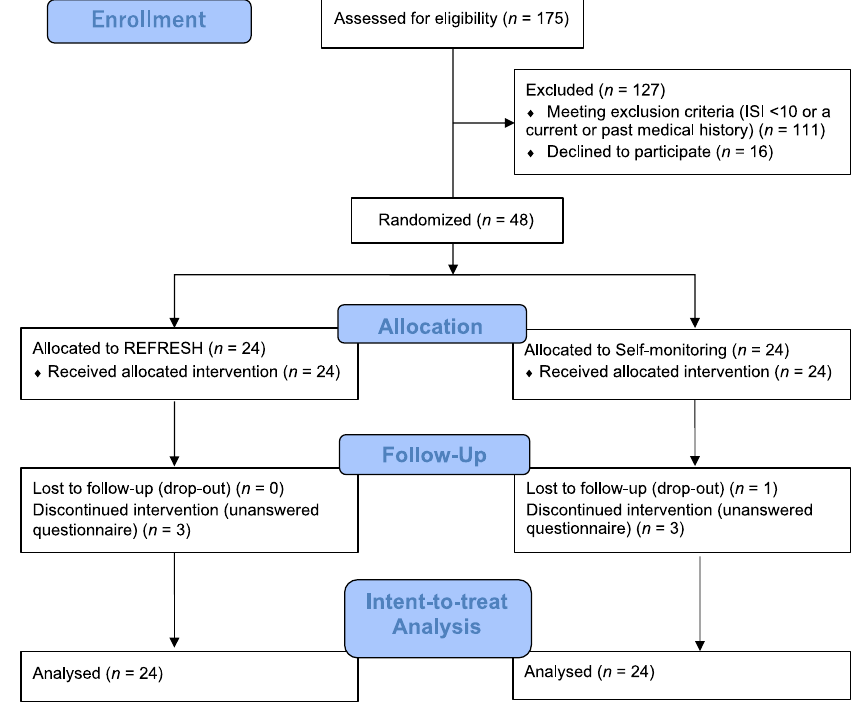
Figure 1. Study flowchart.